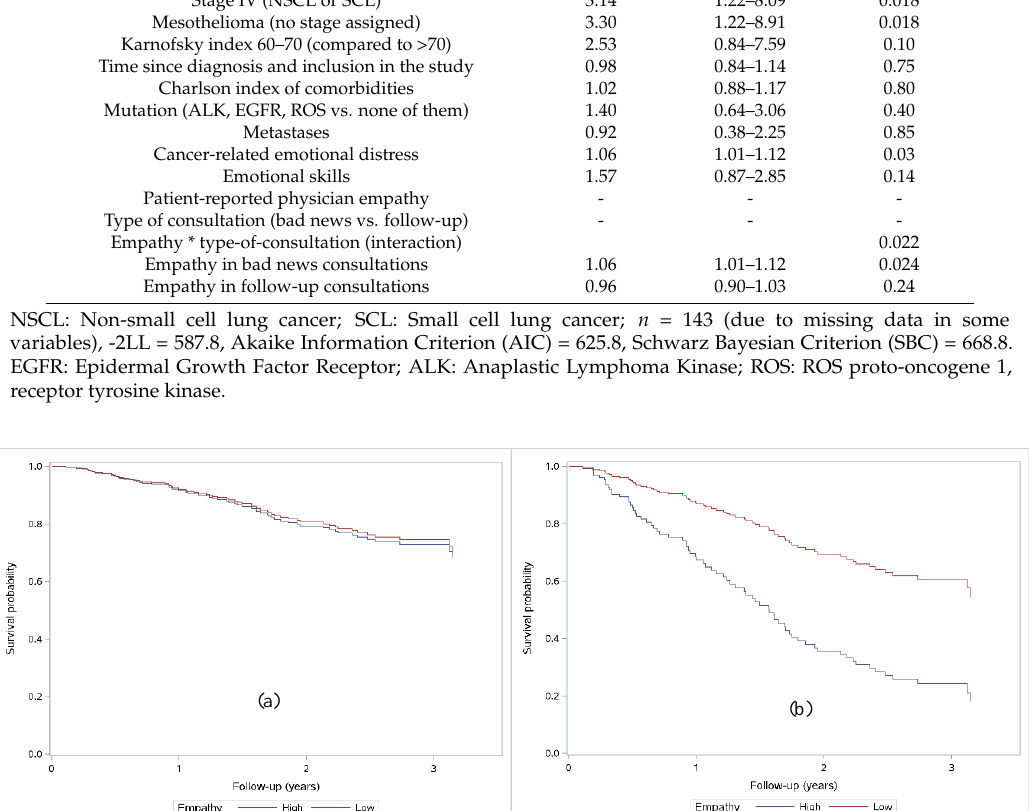
Table 3. Adjusted Cox Proportional Hazard Model for overall survival.